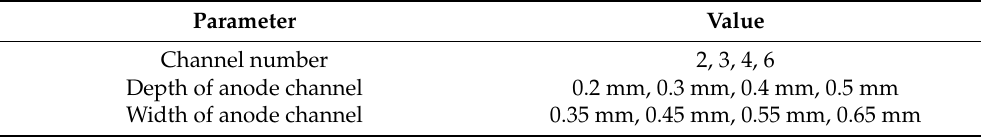
Table 1. Parameters of different anode serpentine flow fields for open-cathode